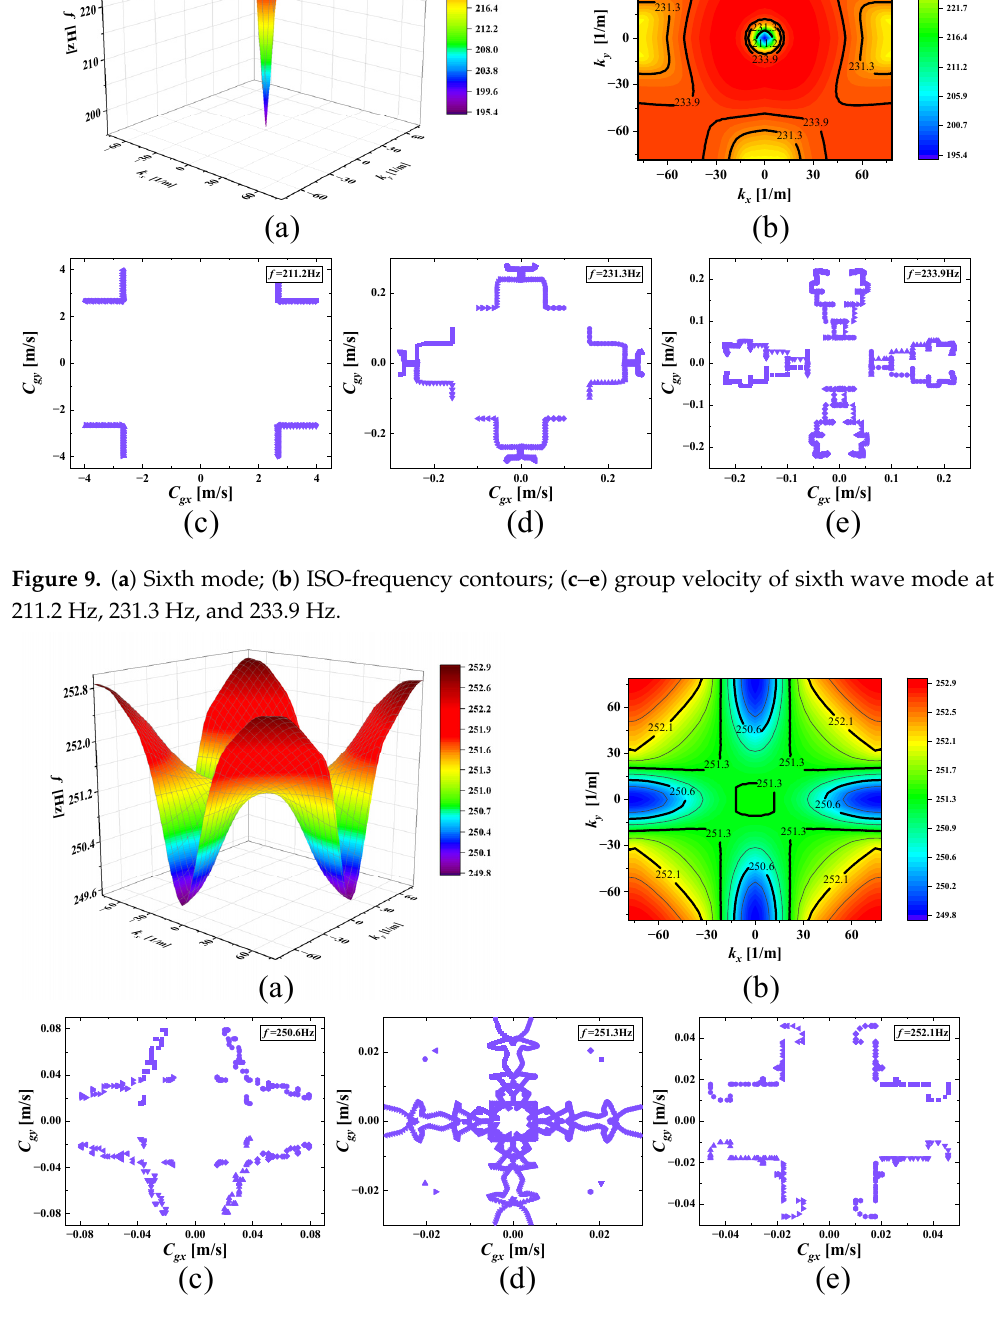
Figure 10. ( a ) Seventh mode; ( b ) ISO-frequency contours; ( c – e ) group velocity of seventh wave mode at 250.6 Hz, 251.3 Hz, and 252.1 Hz.